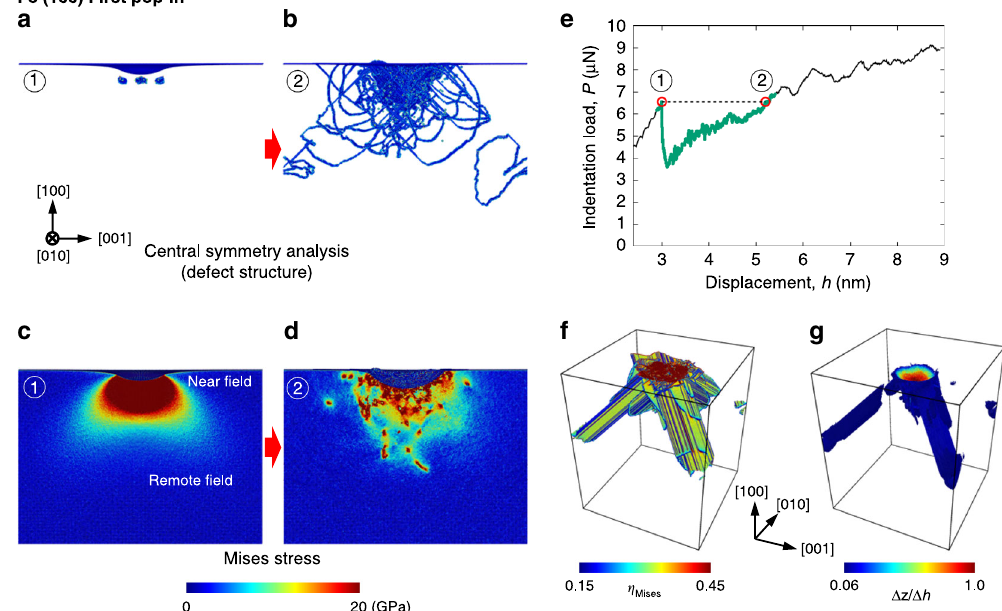
Fig. 3 First pop-in behavior in molecular dynamics simulation at 5 K on the (100) BCC Fe surface. Defect structure immediately ( a ) before and ( b ) after the fi rst pop-in (central symmetry parameter coloring 43 ), von Mises stress distribution immediately ( c ) before and ( d ) after the fi rst pop-in, and ( e ) the corresponding load-displacement curve. f Spatial distribution of von Mises atomic-strain-invariant η Mises . Only atoms satisfying η Mises > 0.15 are displayed. g Spatial distribution of atomic displacement along loading direction ([100]), Δ z , normalized by displacement burst Δ h . Only atoms satisfying Δ z / Δ h > 0.06 are shown. The von Mises stress distribution is shown on a (010) plane passing through the indenter central axis. The movies of the dislocation pattern and the stress-distribution evolution during the simulation can be found in Supplementary Movie 1. See also Supplementary Note 15 for (111) BCC Fe and (100) FCC Cu.